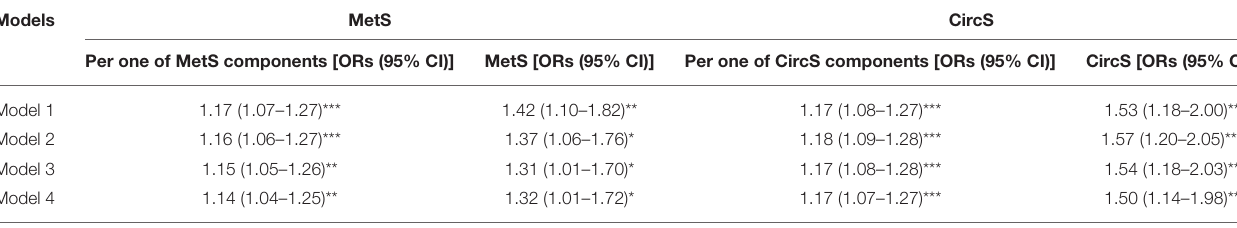
TABLE 2 | The longitudinal association between MetS and CircS status and incident LUTS/BPH (2011–2015). Models